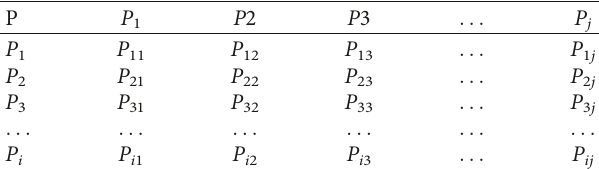
Table 3: Value range of judgment matrix.